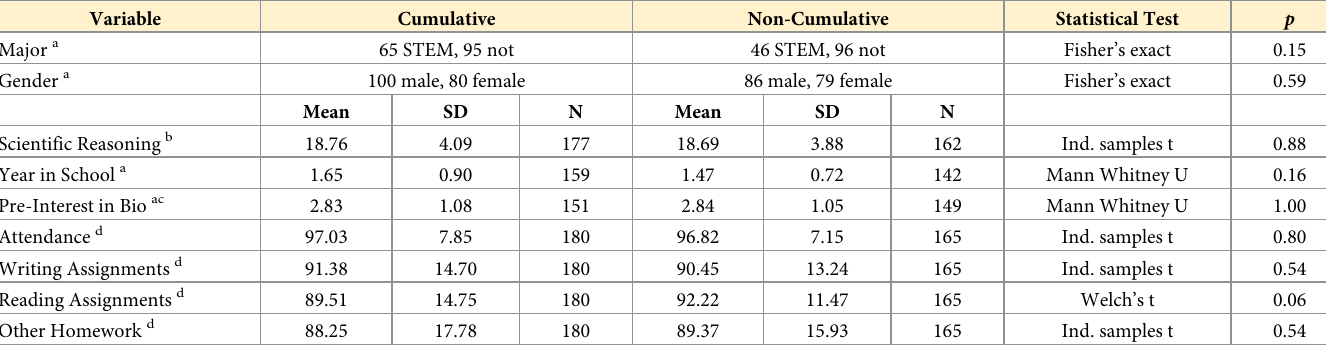
Table 1. Sections were generally